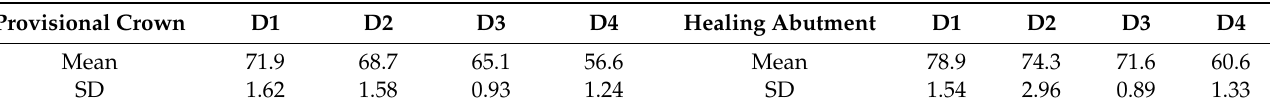
Table 2. Mean and standard deviation of IST by bone